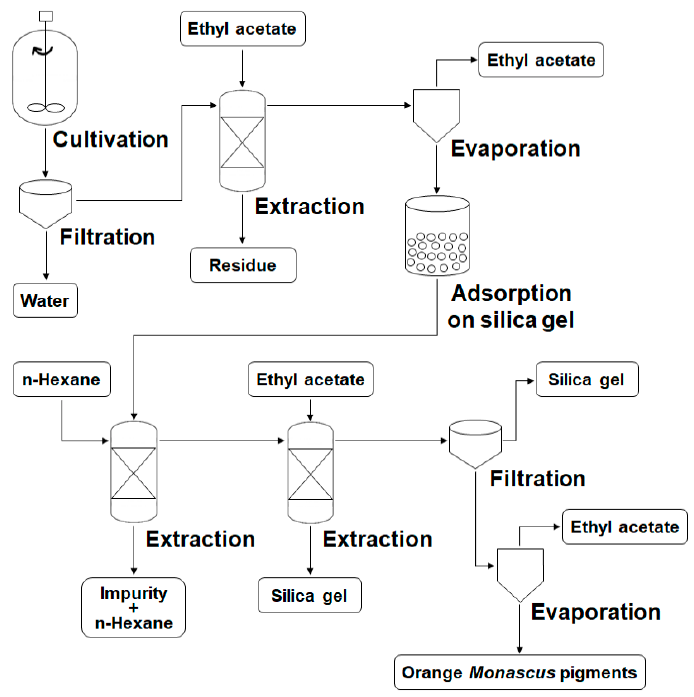
Figure 3. Process flow diagram for the separation and purification of orange Monascus pigments.